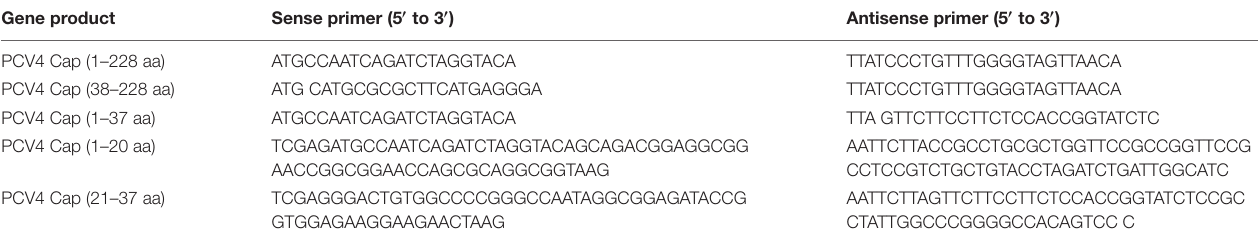
TABLE 1 | List of primers adopted in the study. Gene product Sense primer (5 (cid:48) to 3 (cid:48) ) Antisense primer (5 (cid:48) to 3 (cid:48) )